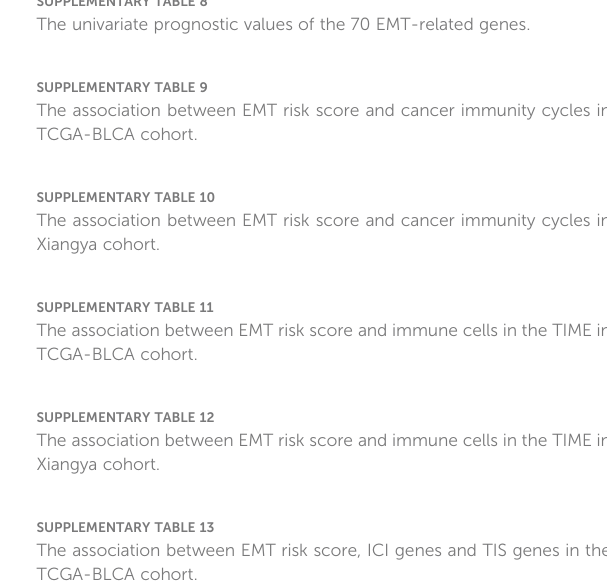
SUPPLEMENTARY TABLE 11 The association between EMT risk score and immune cells in the TIME in TCGA-BLCA cohort.